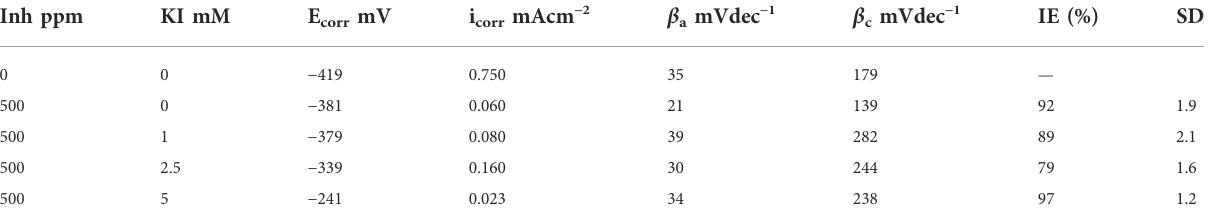
TABLE 3 Obtained values by Tafel extrapolation for 1018 steel corrosion inhibition with 500 ppm of M. sativa and different KI concentrations at 25 ± 2 ° C. Inh ppm